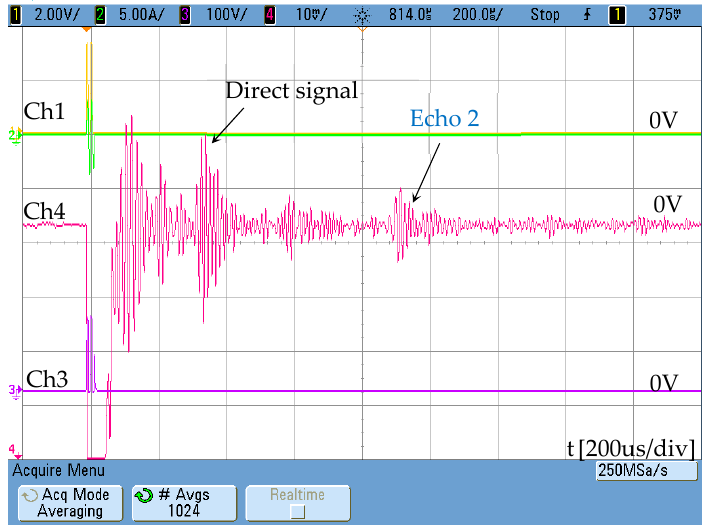
Figure 19. Magnetostrictive transducer response with DC current bias. Ch4: [10 mV/div]. Ch1 shows the activation signal of the power stage [2 V/div] and Ch3 the voltage at resonant circuit [100 V/div]. The maximum AC current is 5 A.